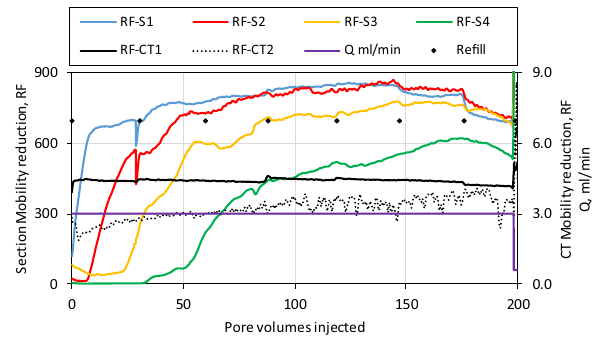
Fig. 16 Experiment 8, 1000 ppm A10 in 3xSSW in Sand col- umn. RF pm and RF CT as a function of pore volumes injected. T = 80 °C. The volumetric injection rate is 3.0 ml/min from 0 to 198 pore vol- umes. The black dots indicate when the polymer solution reservoir was refilled